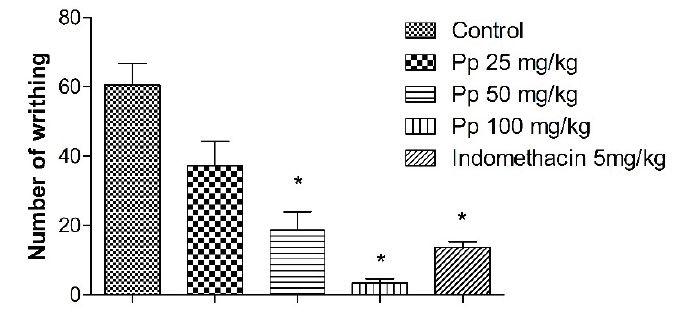
Figure 4. Effect of oral doses of Pp-oil on the nociception induced by intraperitoneal injection of acetic acid. Mean ± s.e.m., * Significantly different from the control ( p < 0.05, F = 22.59, ANOVA, Student-Newman-Keuls t -test) at given a